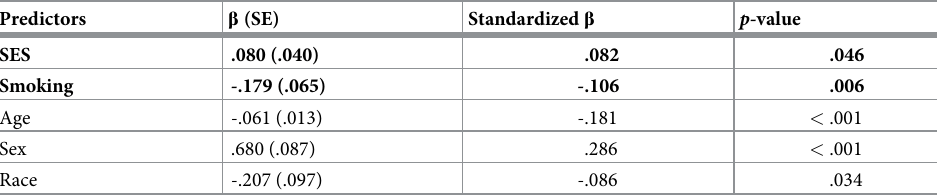
Table 4. Multivariable linear regression Model 3: SES, smoking, and brain